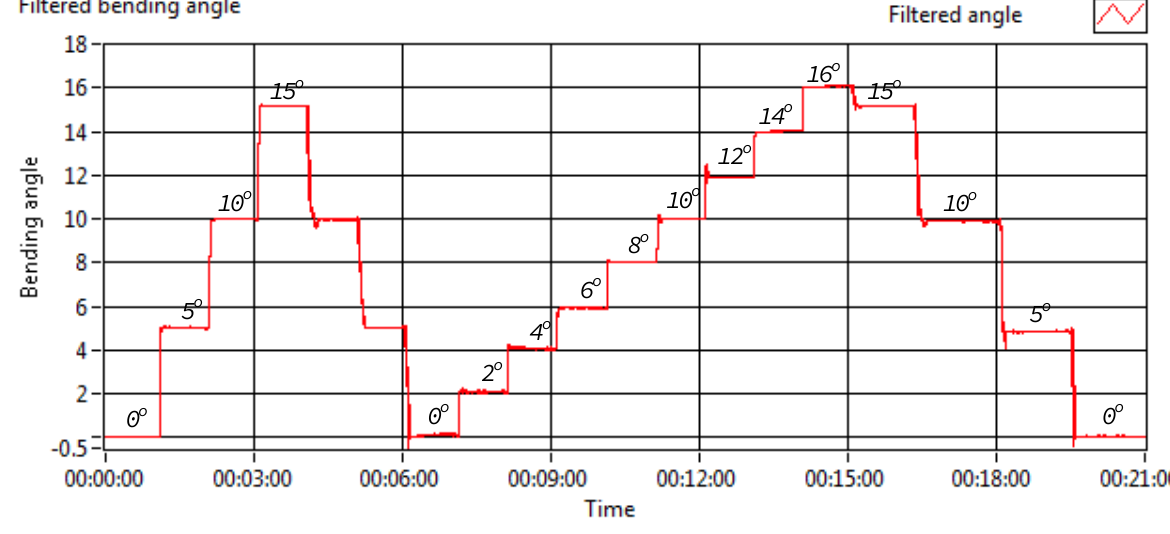
Figure 8. Bending measurement—bending angle ( o ).